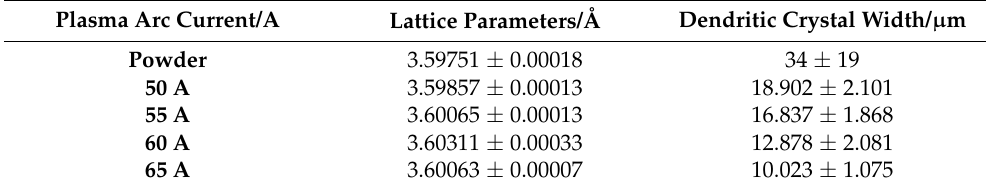
Table 4. Lattice parameters and grain width of dendritic structure of the CoCrFeNiMn HEA powder and coatings prepared at different plasma arc